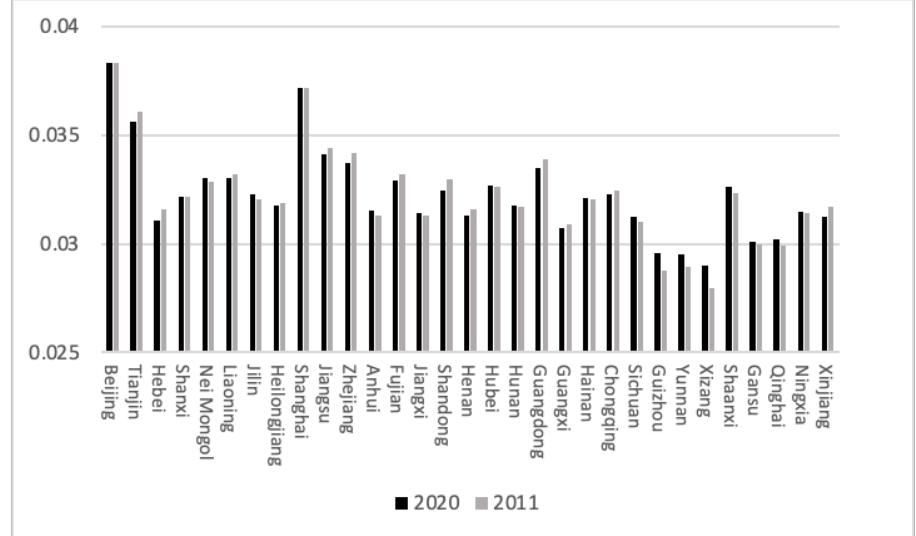
Figure 1. The proportion of HDI in 2011 and 2020. (Source: made by the authors).